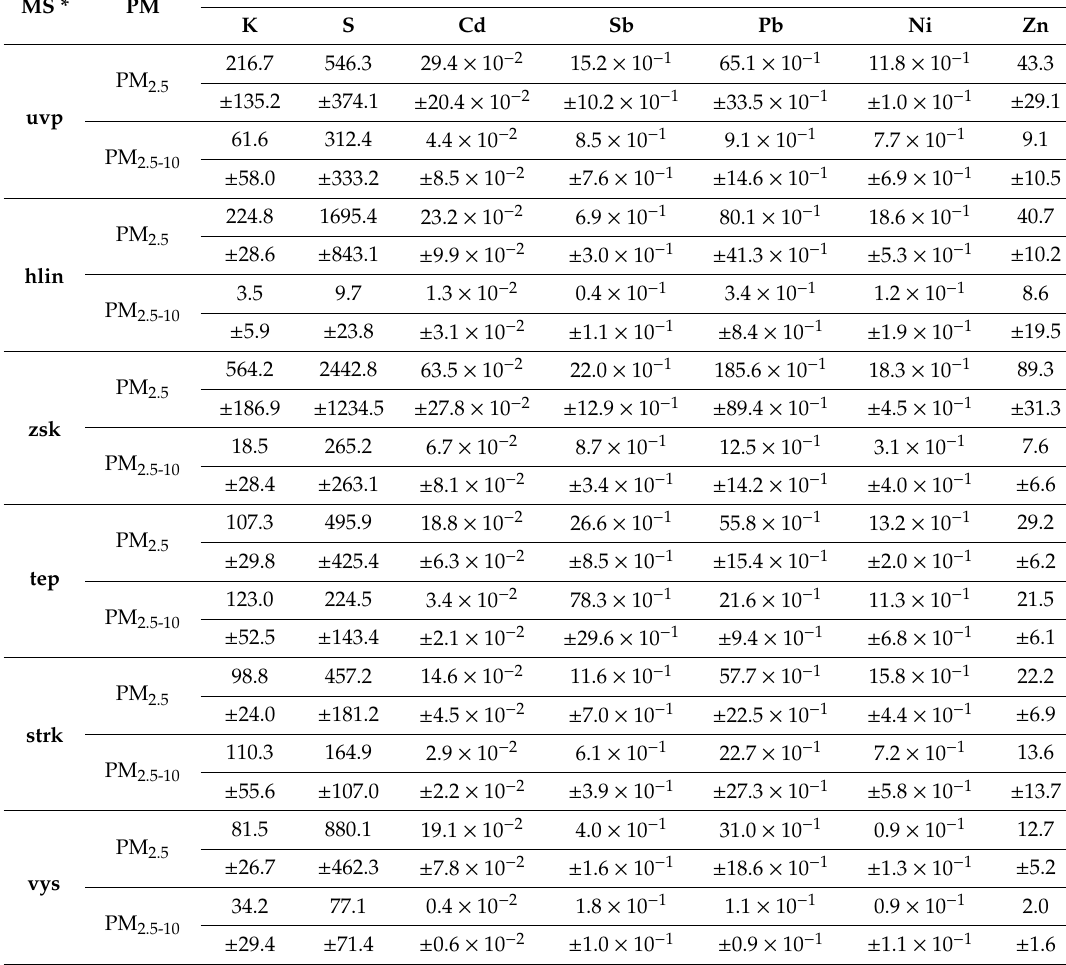
Table 2. Average concentration of elements in the particulate matter (PM) fraction (PM 2.5 and PM 2.5-10 ) at di ff erent measuring stations, with more than 60% in the PM